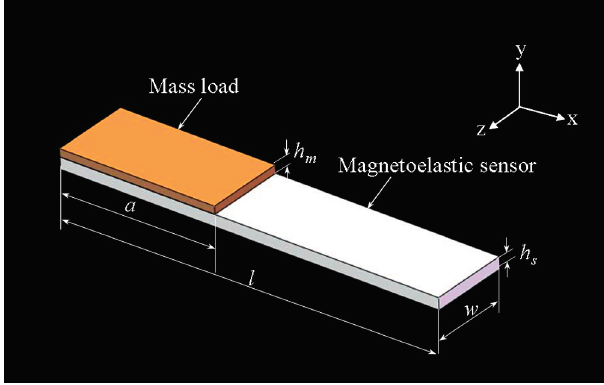
Figure. 1. Illustration of a magnetoelastic sensor (MS) loaded with a layer of uniform mass where l , w , and h s represent the length, width and thickness of the MS; a (0 ≤ a ≤ l ) and h m represent the length and thickness of the mass load